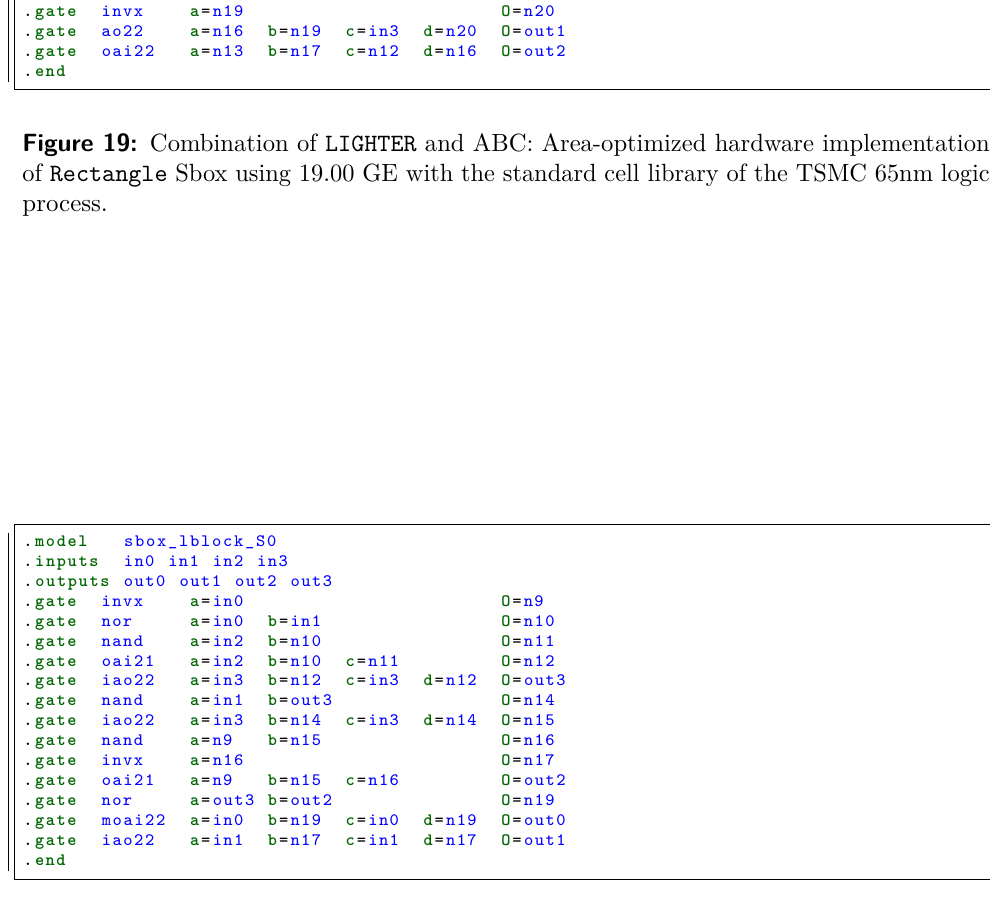
Figure 20: Combination of LIGHTER and ABC: Area-optimized hardware implementation of LBlock Sbox S 0 using 17.50 GE with the standard cell library of the TSMC 65nm logic